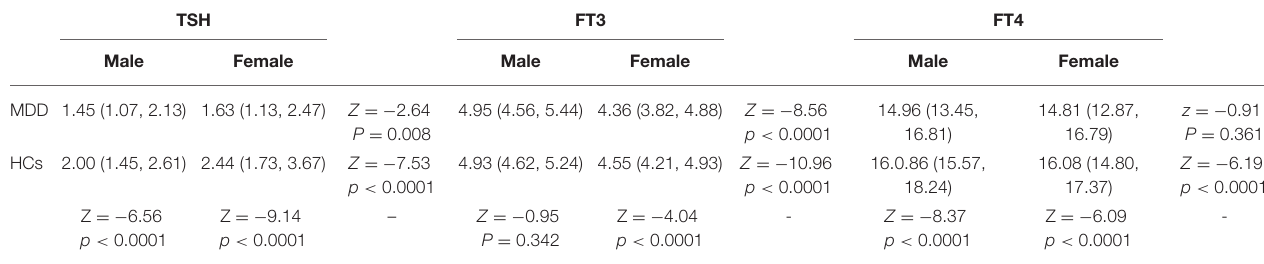
TABLE 1 | Levels of thyroid hormones by gender in the MDD group and the HC group. TSH FT3 FT4 Male Female Male